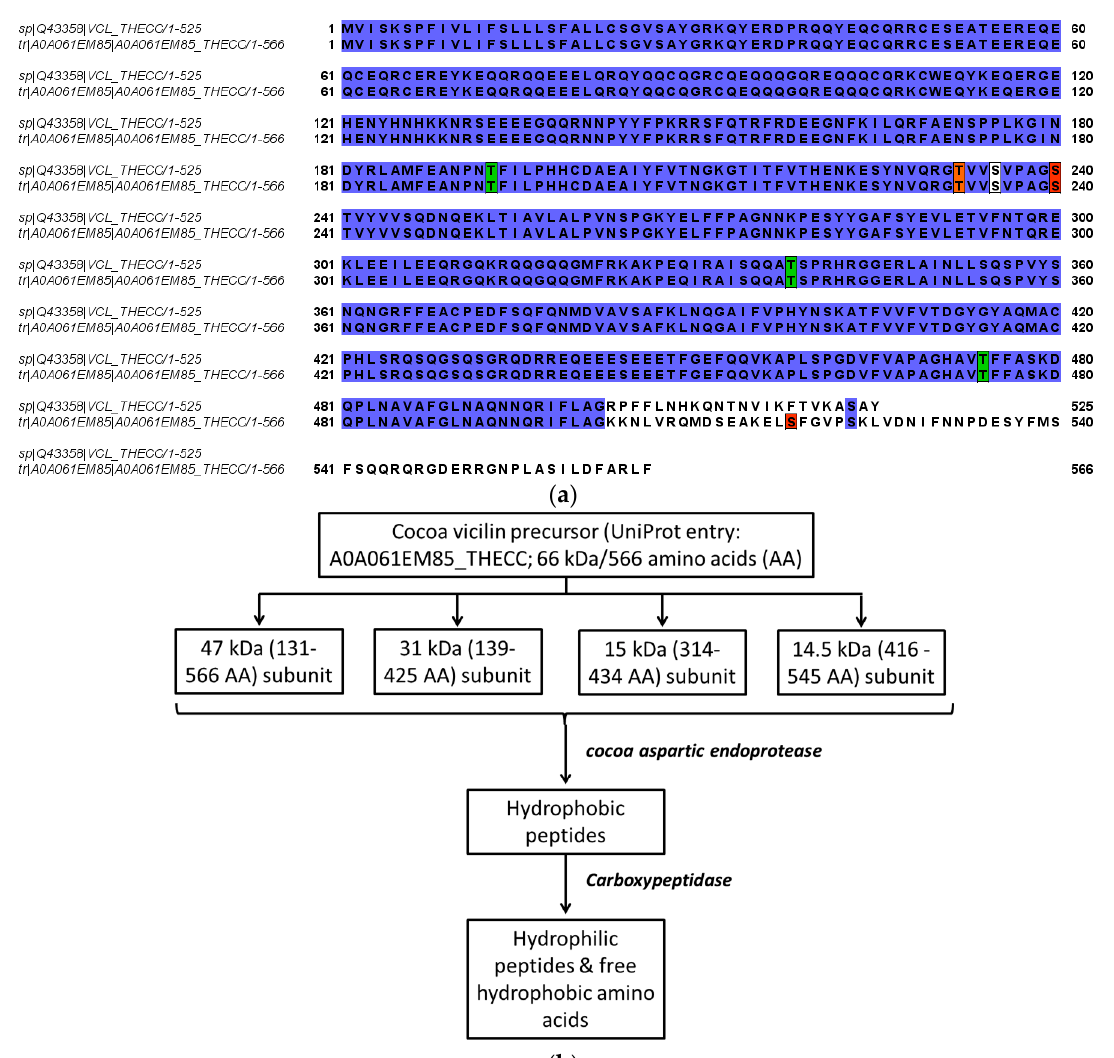
Figure 3. ( a ) Comparison of two entries of the storage protein vicilin from Theobroma cacao (a reviewed and a non-reviewed versions) from the database UniProt (http://www.uniprot.org/; 28th January, 2019) showing the similarities (blue) in the amino acid sequence. Positions for predicted post-translational modifications [50] are marked: phosphorylation (red; at positions 232 (Thr), 235 (Ser), 240 (Ser), and 518 (Ser)), or glycosylation (green; O-GLcNAc modifications at positions 193 (Thr), 235 (Ser), 338 (Thr) and 474 (Thr)). The common residue (white, 235 (Ser)) serves as a possible site for both modifications. ( b ) Postulated degradation of cocoa vicilin precursor during maturation by endogenous enzymes and fermentation adapted from [10–12,22,57]; the 47 kDa subunit may only encompass the sequence 131–545 amino acids [50]. Specific sites for phosphorylation or glycosylation of the subunits are given in Figure 3a [50]. AA represents the amino acid sequence of the subunits.